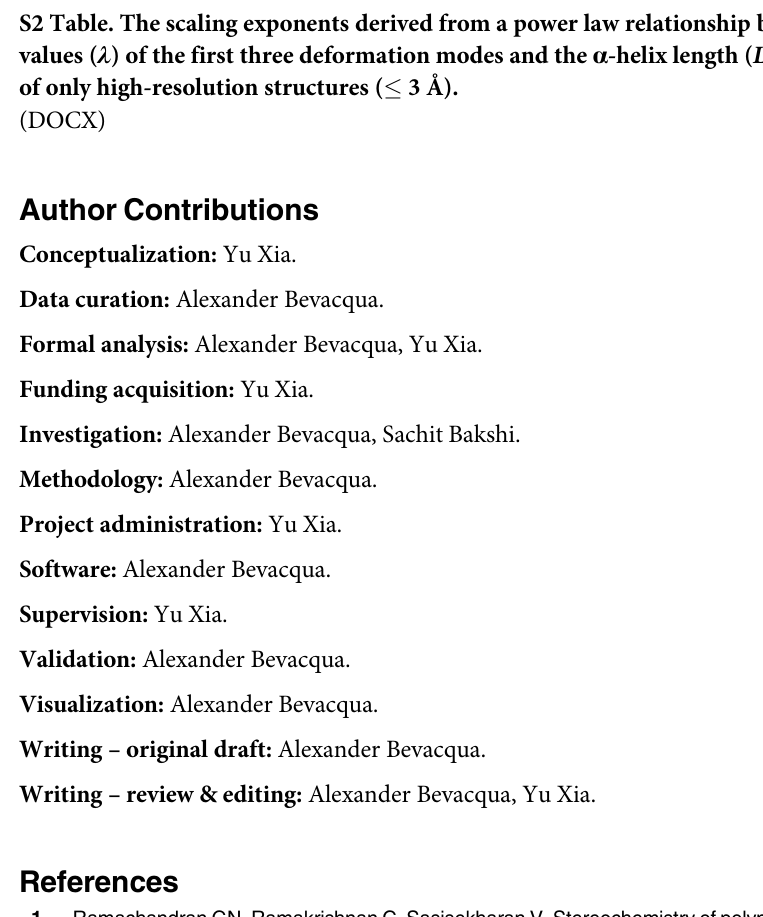
between the z-coordinate of α -carbon 6 in candidate α -helix 3 of the sample and the z-coordi- nate of α -carbon 6 in the mean α -helix is one of many data points in the raw data for PCA. (E) The raw data for PCA is an N by 3 L matrix recording the displacements between each atomic coordinate of the transformed candidate α -helix and the corresponding atomic coordinate in the mean α -helix. S1 Table. The power law relationship between the eigenvalues ( λ ) of the first three defor- mation modes and the α -helix length ( L ). S2 Table. The scaling exponents derived from a power law relationship between the eigen- values ( λ ) of the first three deformation modes and the α -helix length ( L ) for our analysis of only high-resolution structures ( � 3 Å